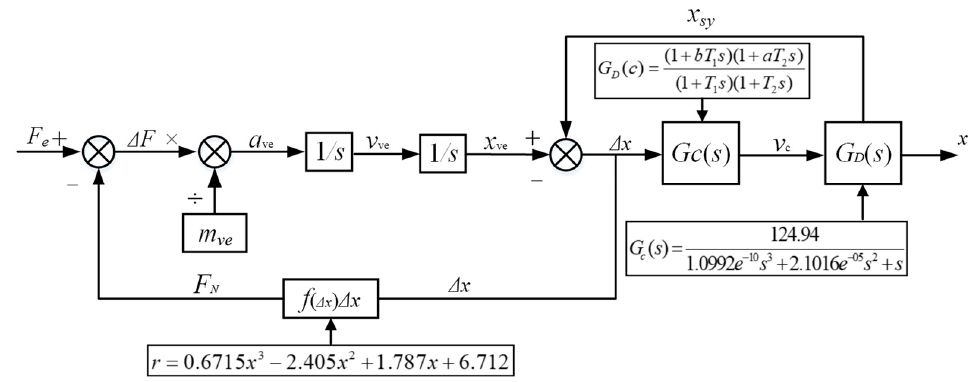
Figure 6. Active control strategy block diagram.